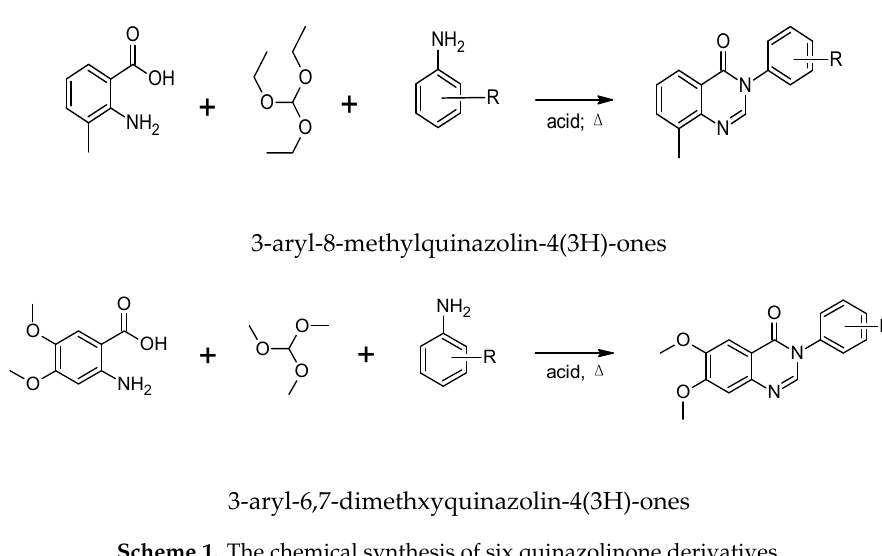
Table 3. H-NMR and EI-MS chemical characterization results.